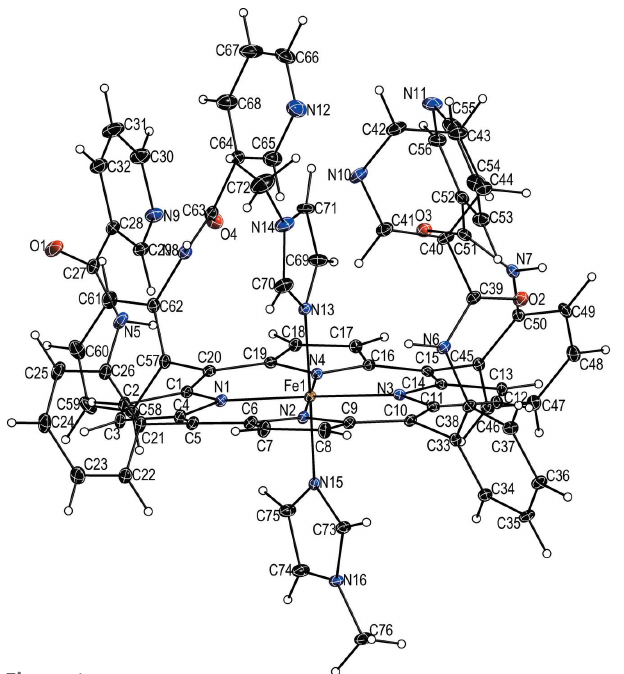
Figure 1 The molecular entities in the title compound, with displacement ellipsoids drawn at the 25% probability level. The 1-methylimidazole and tetrahydrofuran solvent molecules are omitted for clarity.